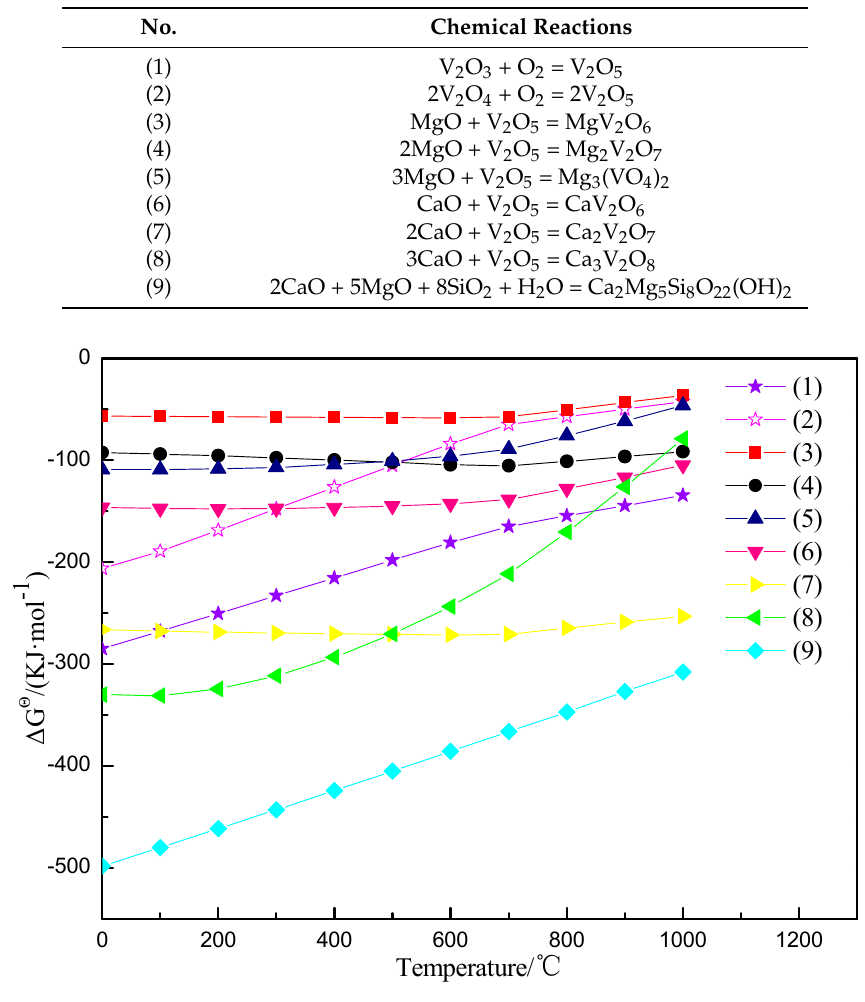
Figure 11. Standard Gibbs free energy changes for main chemical reaction at different temperatures during the stone coal roasting process.